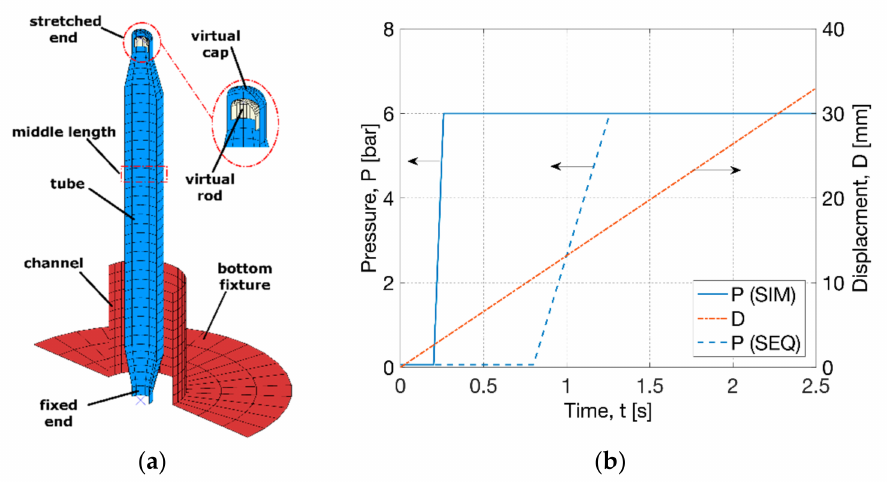
Figure 3. Process simulation for free stretch blow: ( a ) Finite element analysis (FEA) model, ( b ) pressure load and displacement